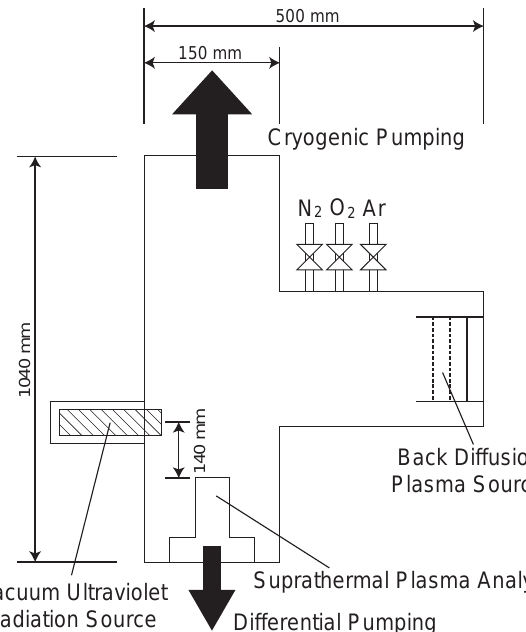
Fig. 2. Experimental set up to measure second harmonic compo- nent which provides energy distribution of electrons in thermal en- ergy range. The test chamber is evacuated using a cryo-genic pump. The sensor part is pumped by another turbo-molecular pump.